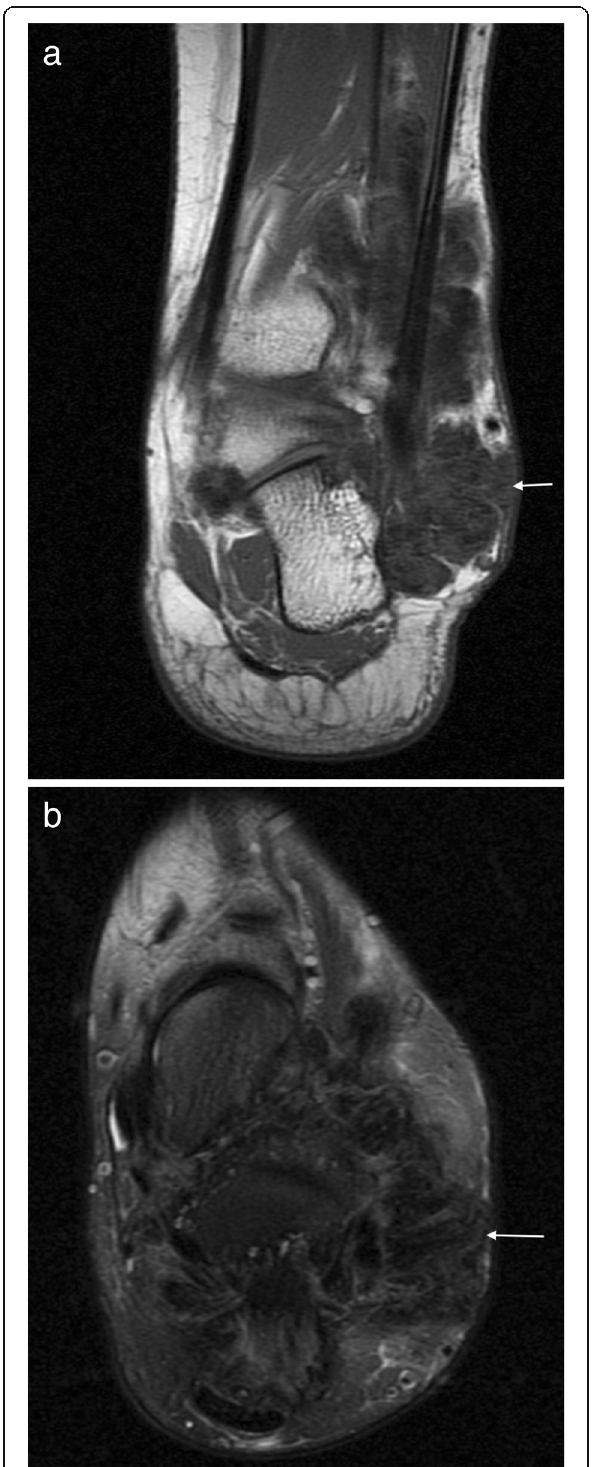
Fig. 7 PVNS. Coronal T1 ( a ) and axial T2FS ( b ) images of the ankle demonstrating extensive abnormal soft tissue with intermediate signal on T1W and hypointense on T2FS